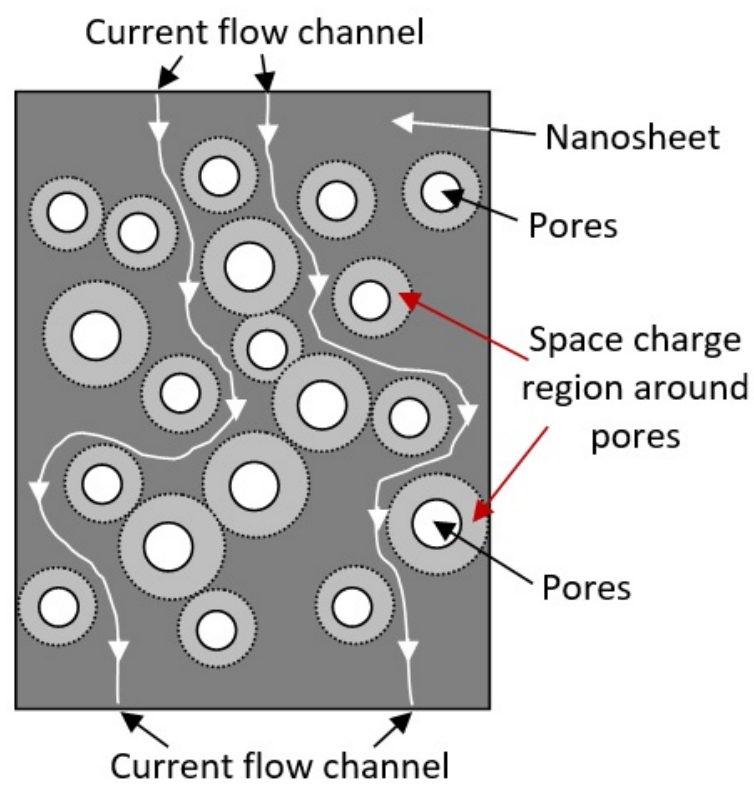
Figure 4. Diagram illustrating the mechanism of current flow channel formation in porous two-dimensional nanostructures. When oxidizing gases are detected, the space charge regions expand, and current flow channels are blocked.